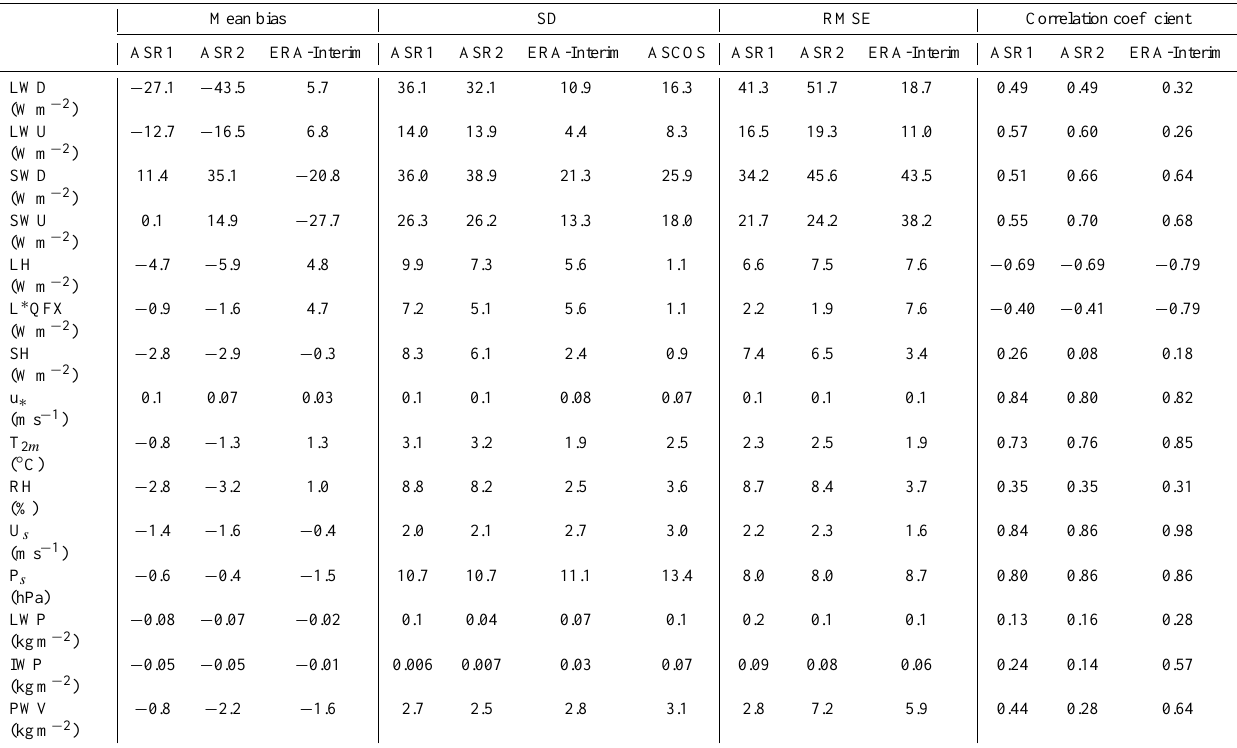
Table 2. Summary of model errors: mean bias, standard deviation within each data set (SD), root-mean-square error (RMSE) and correlation coefficient between each reanalysis and the ASCOS